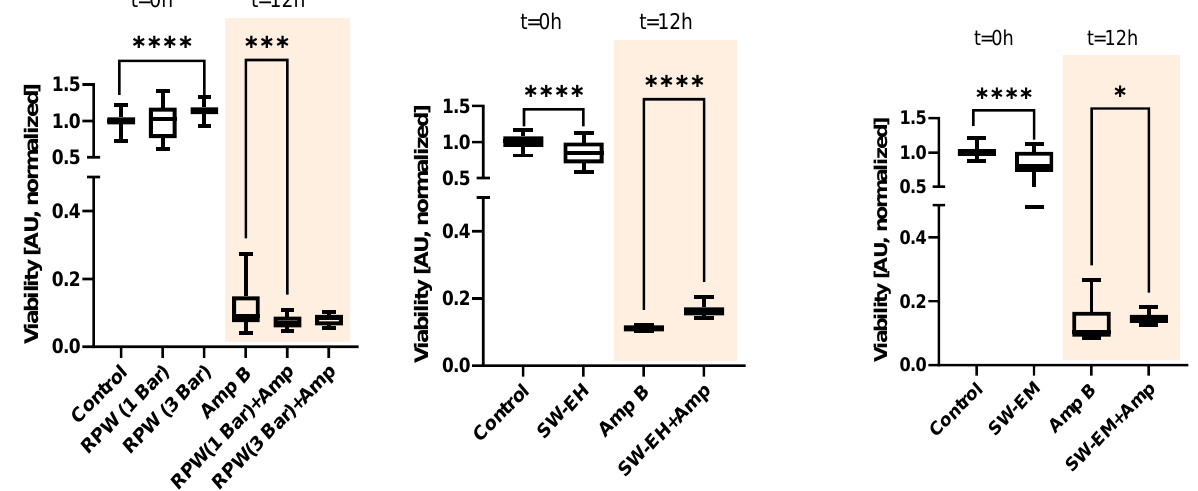
Figure 2. Immediate acute (t = 0) and longitudinal (t = 12 h) effects of Amp B with or without acoustical pressure wave treatment on R. oryzae biofilms. The figure shows normalized XTT absorption for healthy and Amp-B-treated (8 μg/mL in 1% DMSO) biofilm when treated with pressure waves/shockwaves. While radial pressure waves ( left ) had a synergistic effect on Amp B efficacy (AU 0.11 → 0.07 and → 0.08 for 1 and 3 bar, respectively), both SW-EC ( center , AU 0.11 → 0.17) and SW-EM ( right , AU 0.10 → 0.14) prevented Amp B-mediated cell death after 12 h (* p > 0.05. *** p > 0.001 **** p > 0.0001).